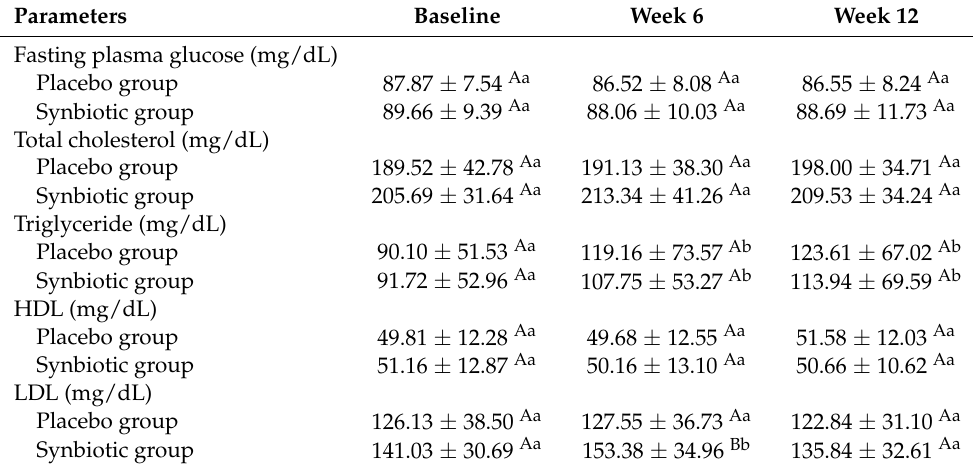
Table 3. Effect of 12-week synbiotic intervention on biochemical profiles in overweight and obese subjects.